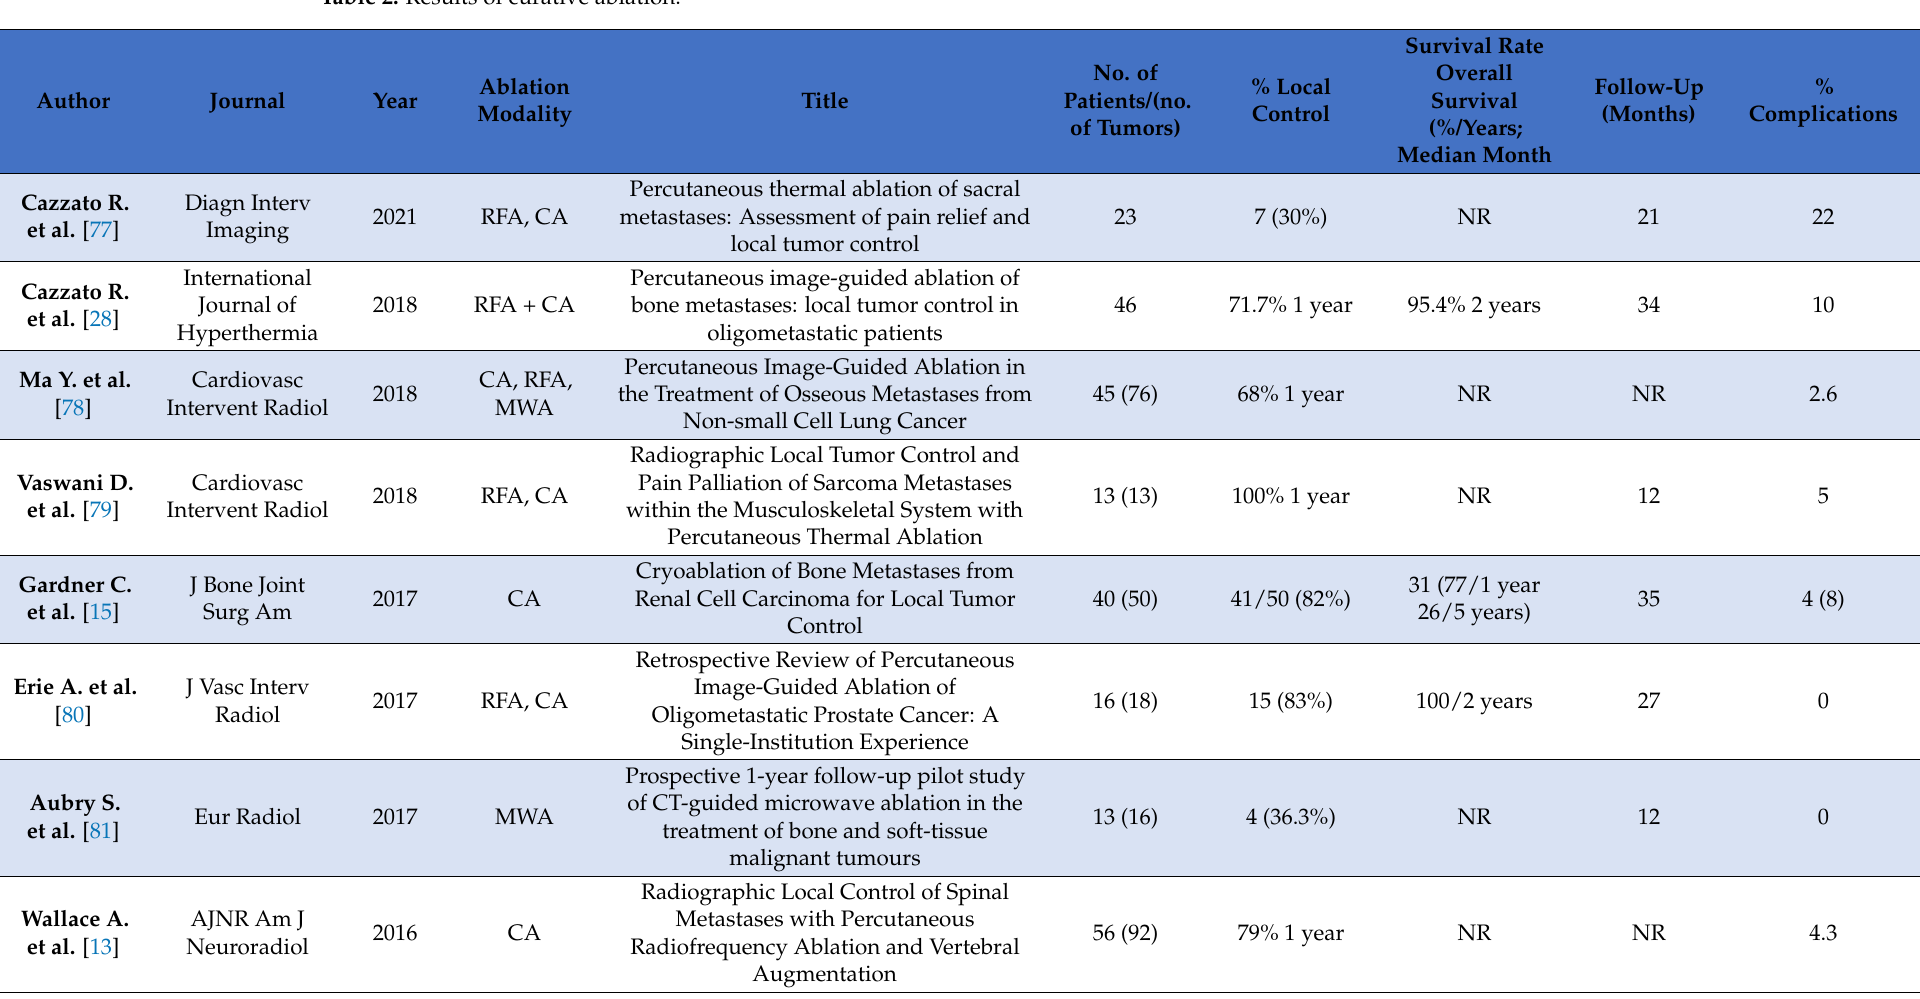
Table 2. Results of curative